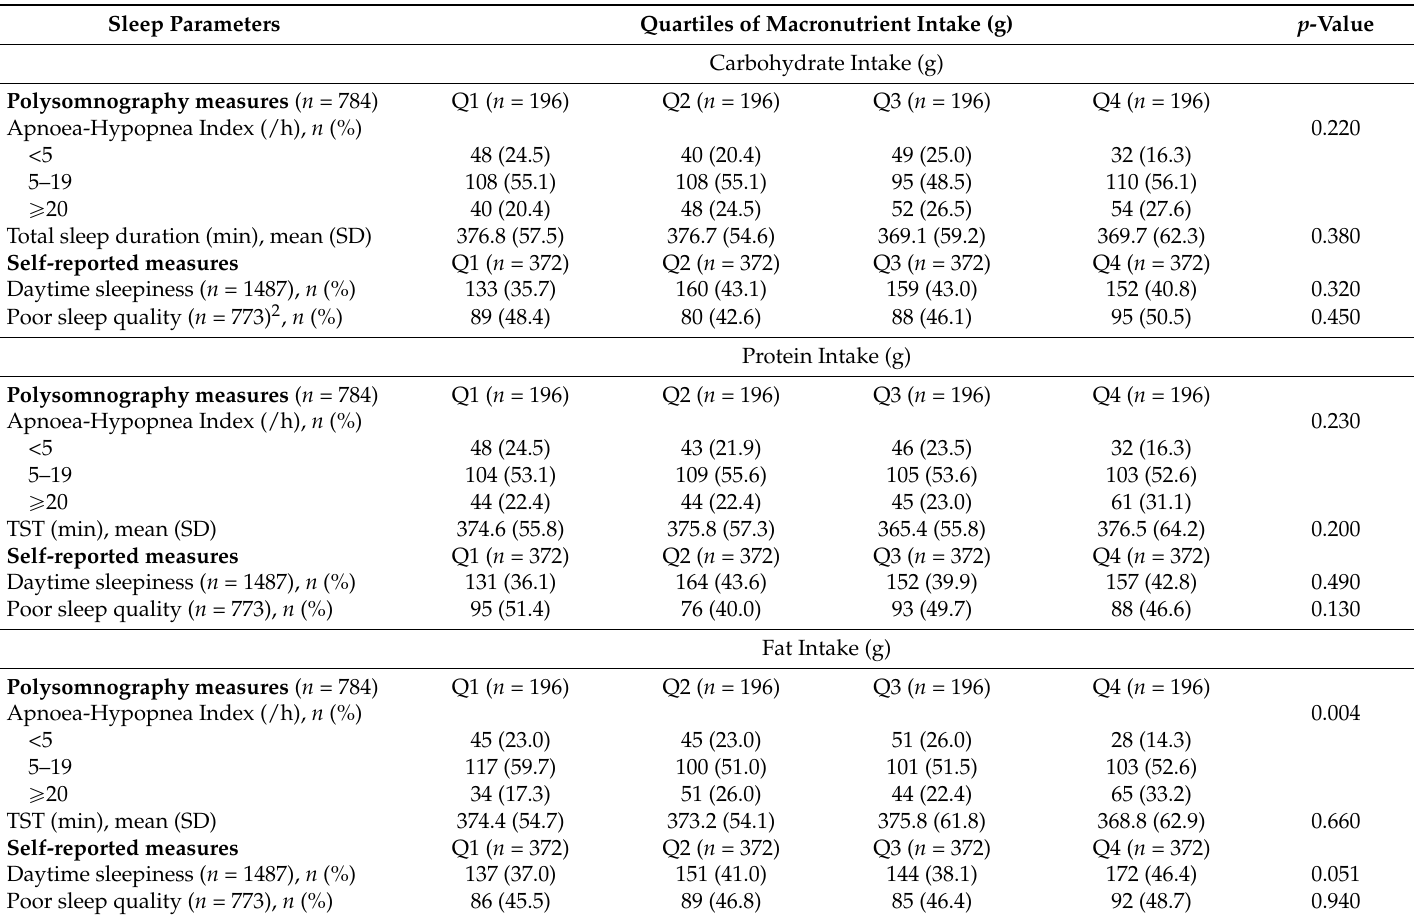
Table 2. Polysomnography and self-reported sleep measures by quartiles of macronutrient intake in grams 1